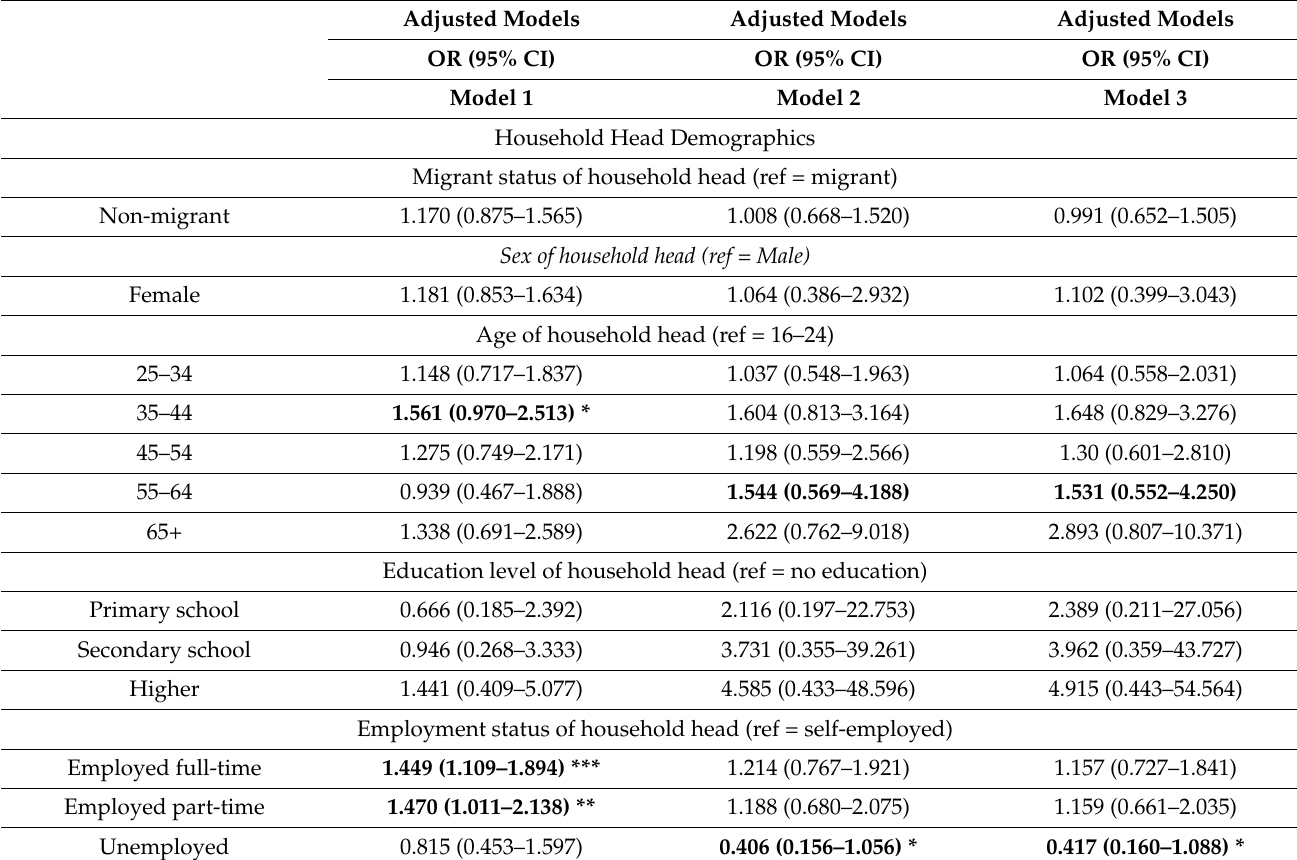
Table 3. Multivariate Analysis of Food Remittances to Urban